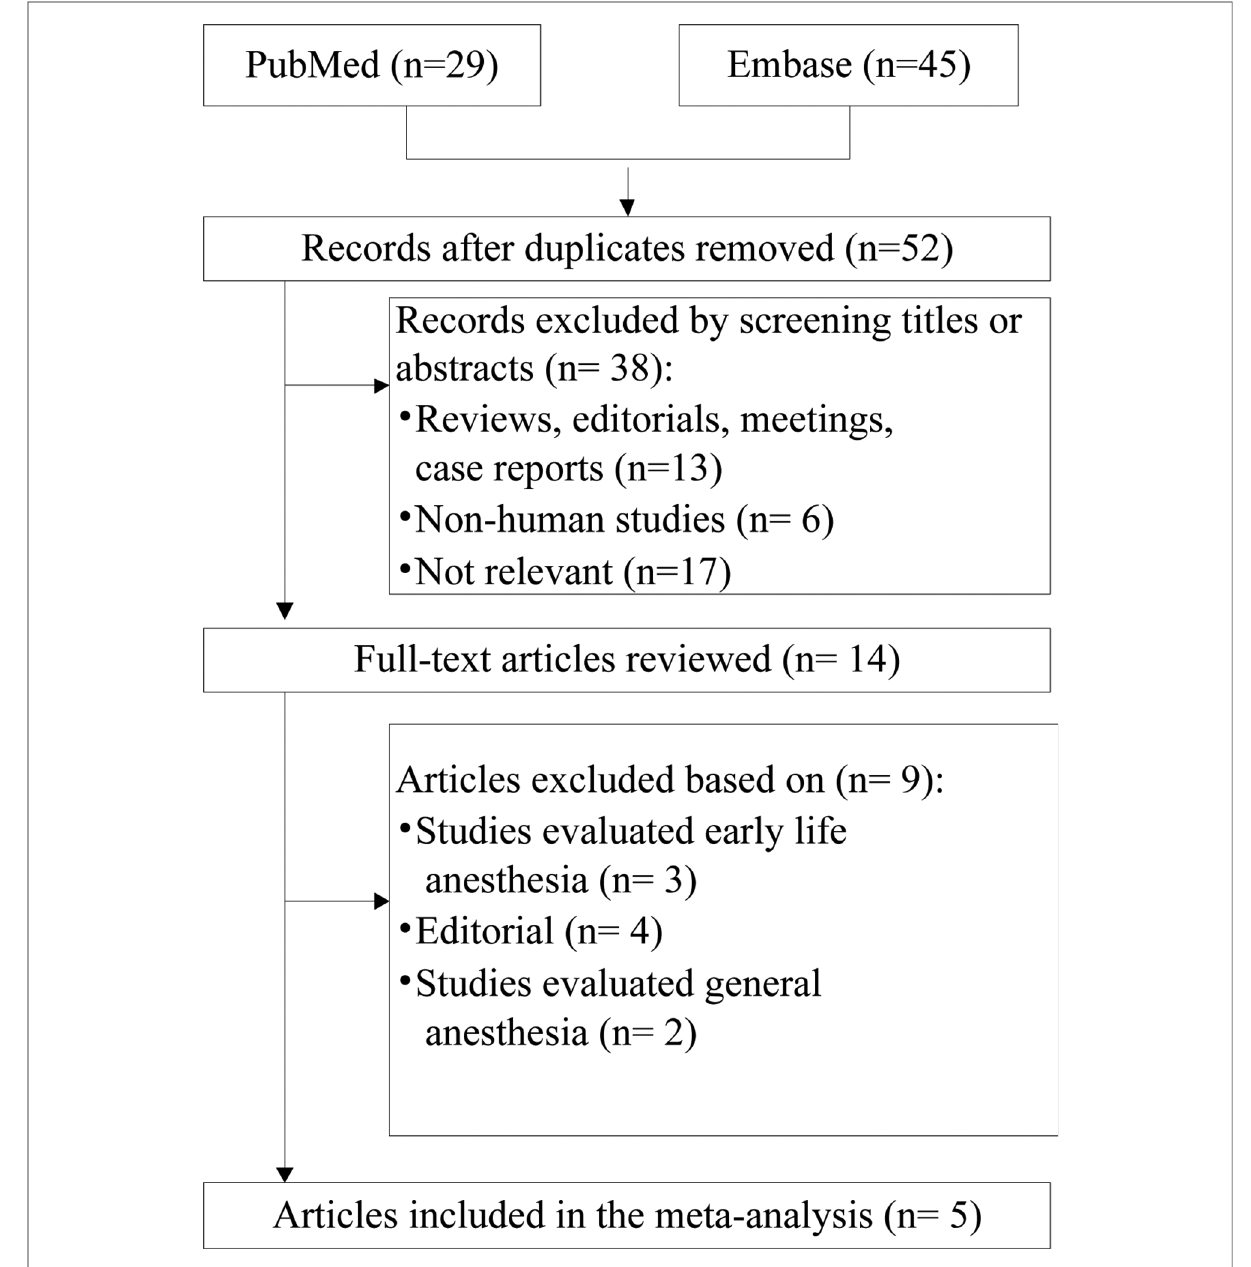
FIGURE 1 Flow chart of the studies considered and fi nally selected for